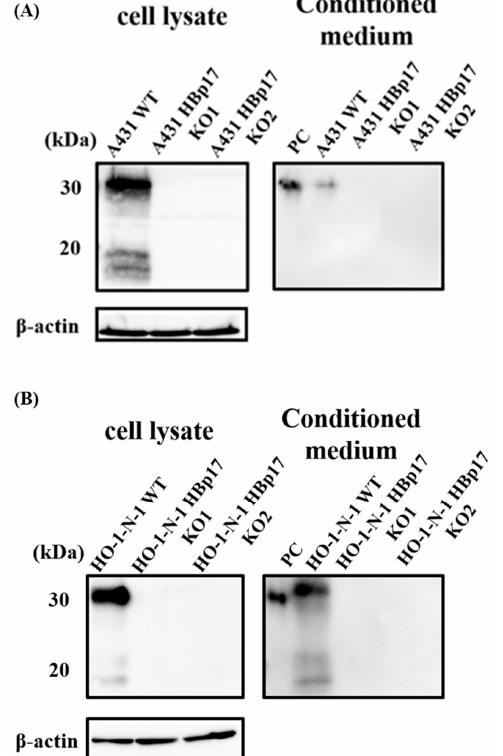
Figure 1. Identification of A431-HBp17-KO and HO-1-N-1-HBp17-KO cells. Cellular protein and CM from A431-HBp17-KO1, -KO2, A431-WT, HO-1-N-1-HBp17-KO1, -KO2, and HO-1-N-1-WT cells were Western blotted against HBp17 goat polyclonal antibody. The absence of the band seen in A431-WT and HO-1-N-1-WT samples confirmed the deletion of HBp17 expression in A431-HBp17-KO ( A ) and HO-1-N-1-HBp17-KO ( B ) cells. Recombinant human HBp17 (2 ng) was used as a positive control